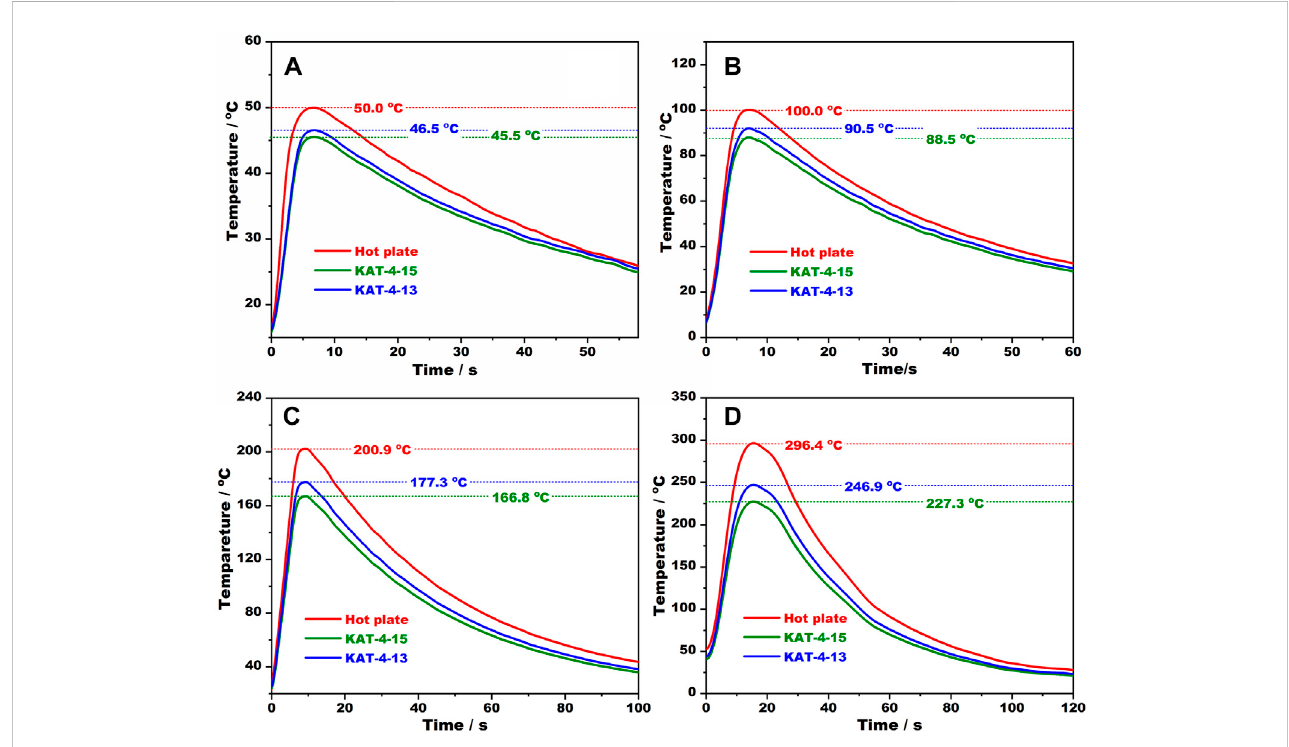
FIGURE 7 The variations of theouter surface temperatureof the aerogel fabrics, placed on a hot plate of different temperatures: (A) 50 ° C, (B) 100 ° C, (C) 200 ° C and (D) 300 ° C.